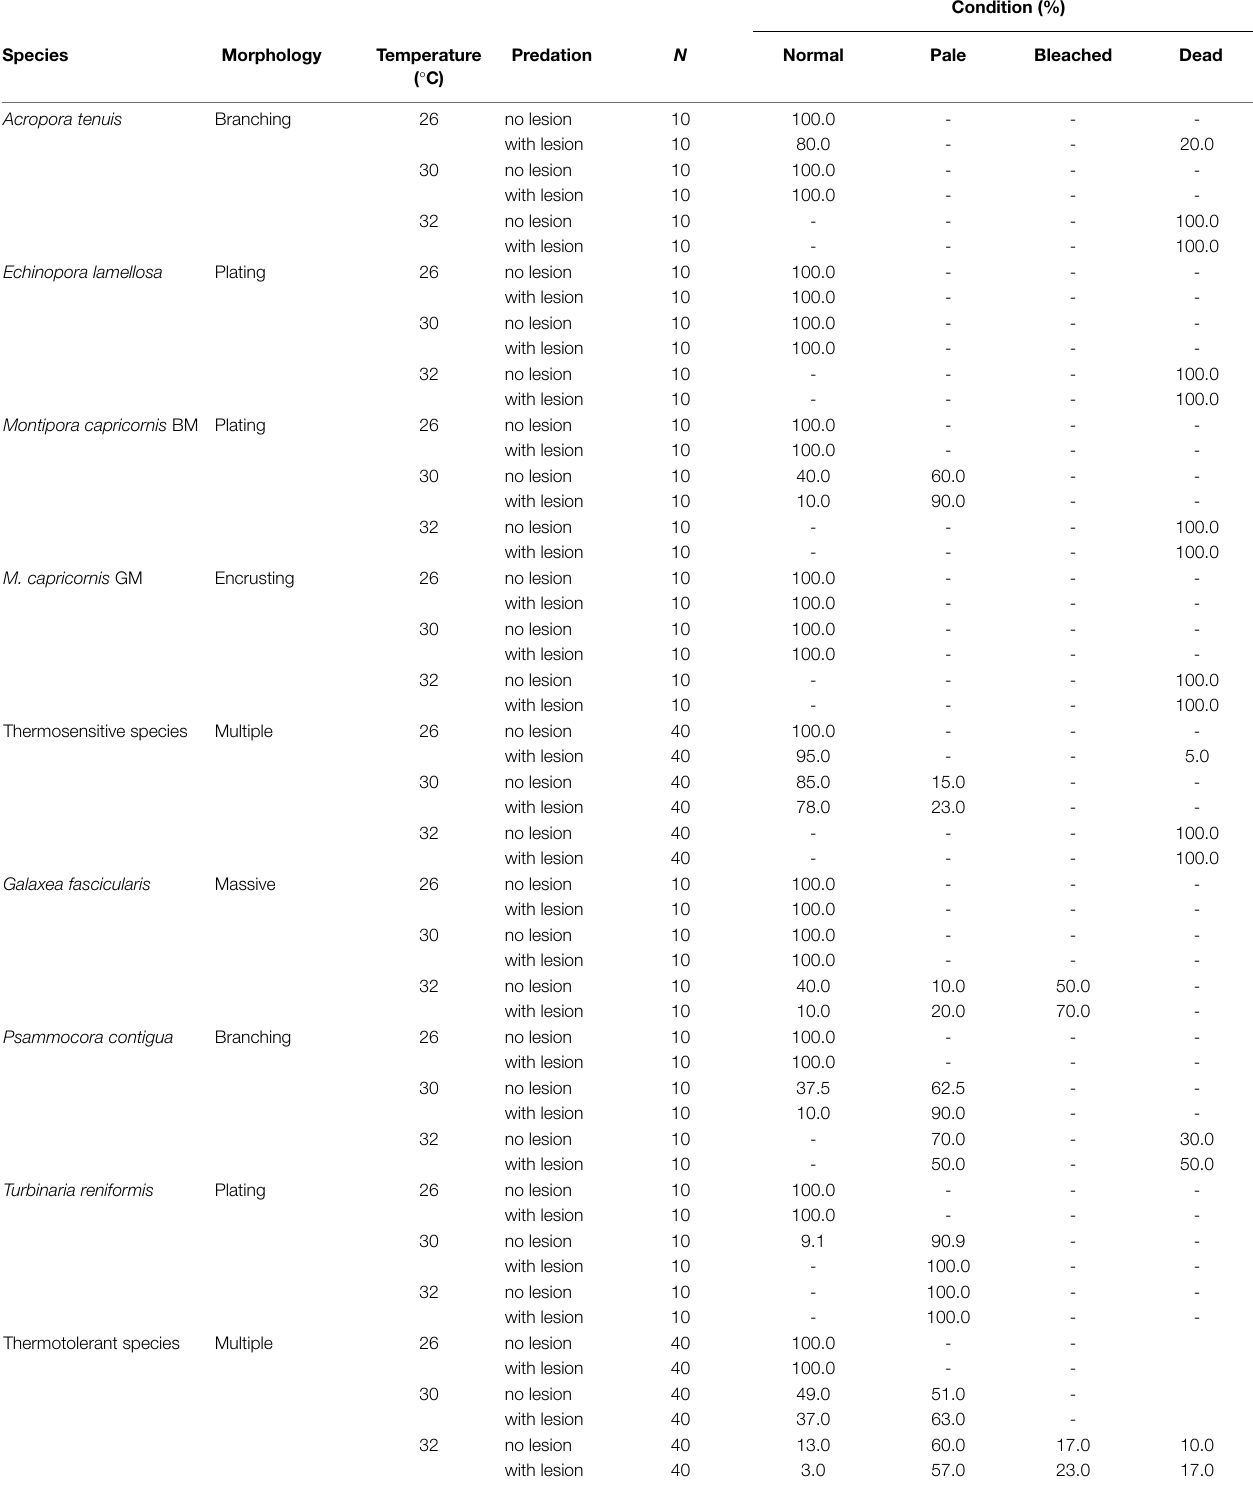
TABLE 1 | Summary of coral health condition [normal, pale, bleached, and dead (%)] per individual species and grouped species (thermosensitive vs. thermotolerant) and treatment tested at 60 days (N total = 420 coral